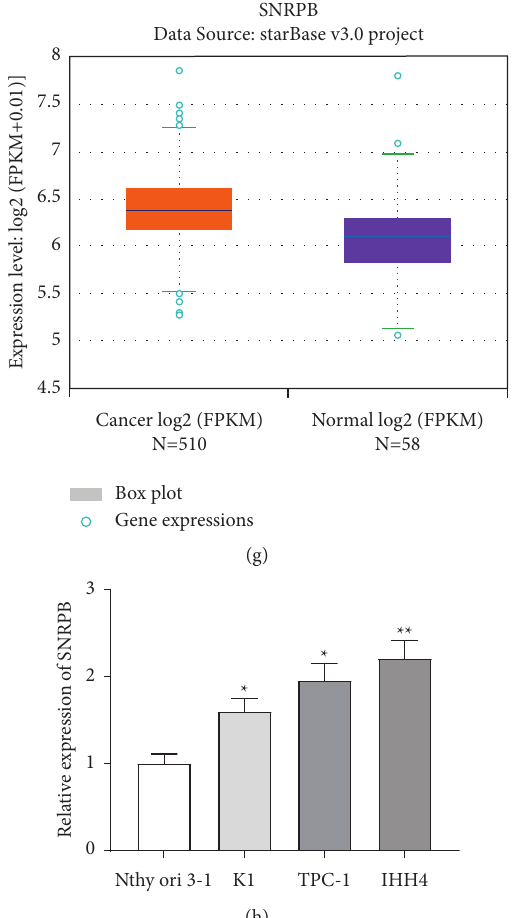
Figure 4: SNRPB is a target gene of miR-151b. (a) ENCORI predicted the target genes of miR-151b. (b, c) SNRPB showed the lowest expression level after miR-151b overexpression in TPC-1 and IHH4 cells. (d) The protein level of SNRPB was detected by western blot. (e) TargetScan predicted the binding site between miR-151b and SNRPB. (f) Luciferase reporter gene assay showed that miR-151b decreased the luciferase activity in the SNRPB-WTgroup. (g) ENCORI showed the high expression of SNRPB in THCA samples. (h) The expression level of SNRPB in THCA cell lines was examined by RT-qPCR. ∗ P < 0 . 05; ∗∗ P < 0 .